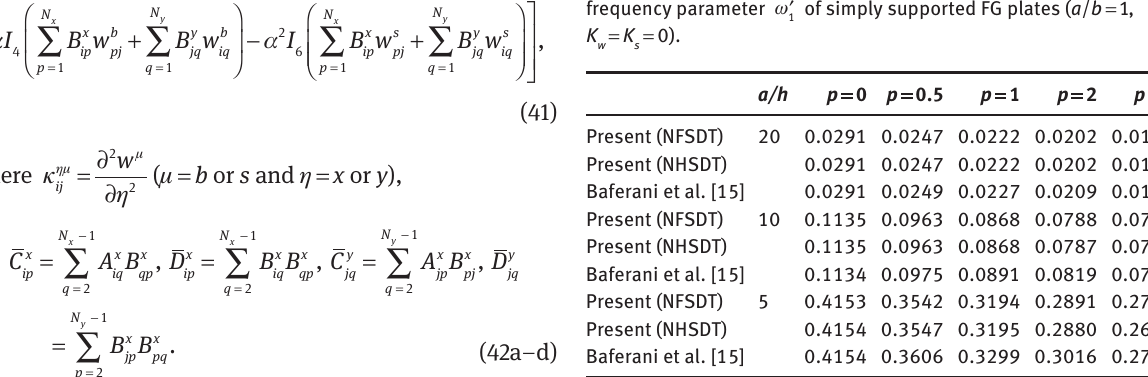
of simply supported FG plates ( a / b = 1, 1